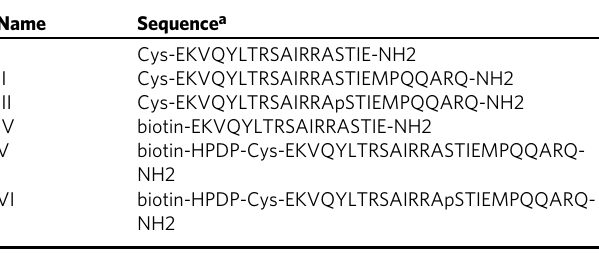
a PLN amino-acid sequences are shown in single letter code. Peptide modi fi cations include: Cys cysteine residue, NH2 C-terminal amidation, biotin amino terminal linked biotin-group;